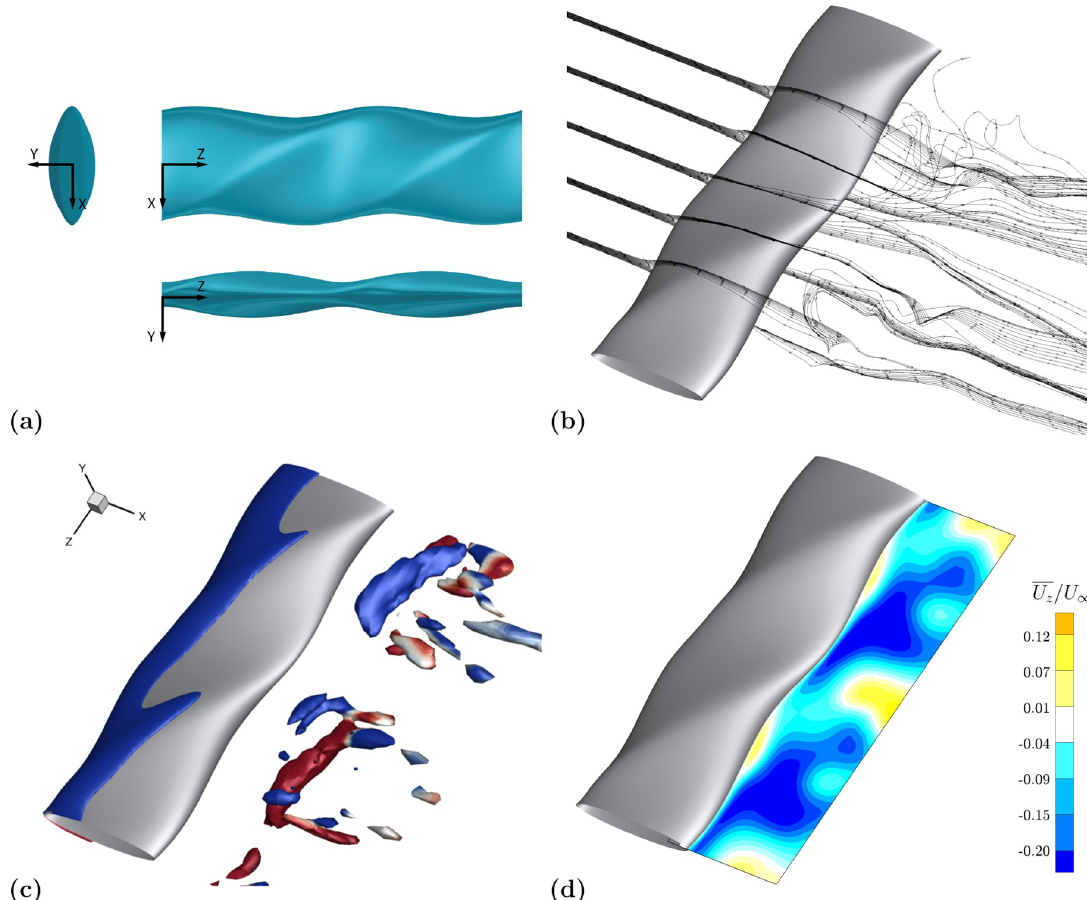
Fig 15. Flow visualization for high ϕ and � geometry. Flow visualization reveals disjointed vortex structures and a preferential direction for the spanwise velocity. (a) EL4 (high � and high ϕ ): top view in the x - z plane, front view in the y - z plane, and side view in the x - y plane. (b) Velocity streamlines at equally spaced spanwise locations as described in Fig 11. (c) Isosurfaces of nondimensional Q -criterion value 0.8, colored by positive (red) and negative (blue) z -vorticity. (d) Mean spanwise velocity in x - z plane.